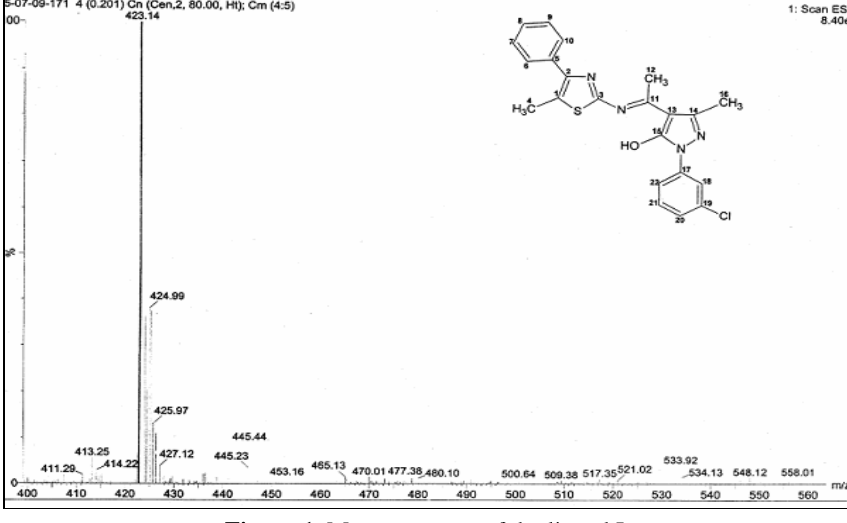
Figure 1. Mass spectrum of the ligand L